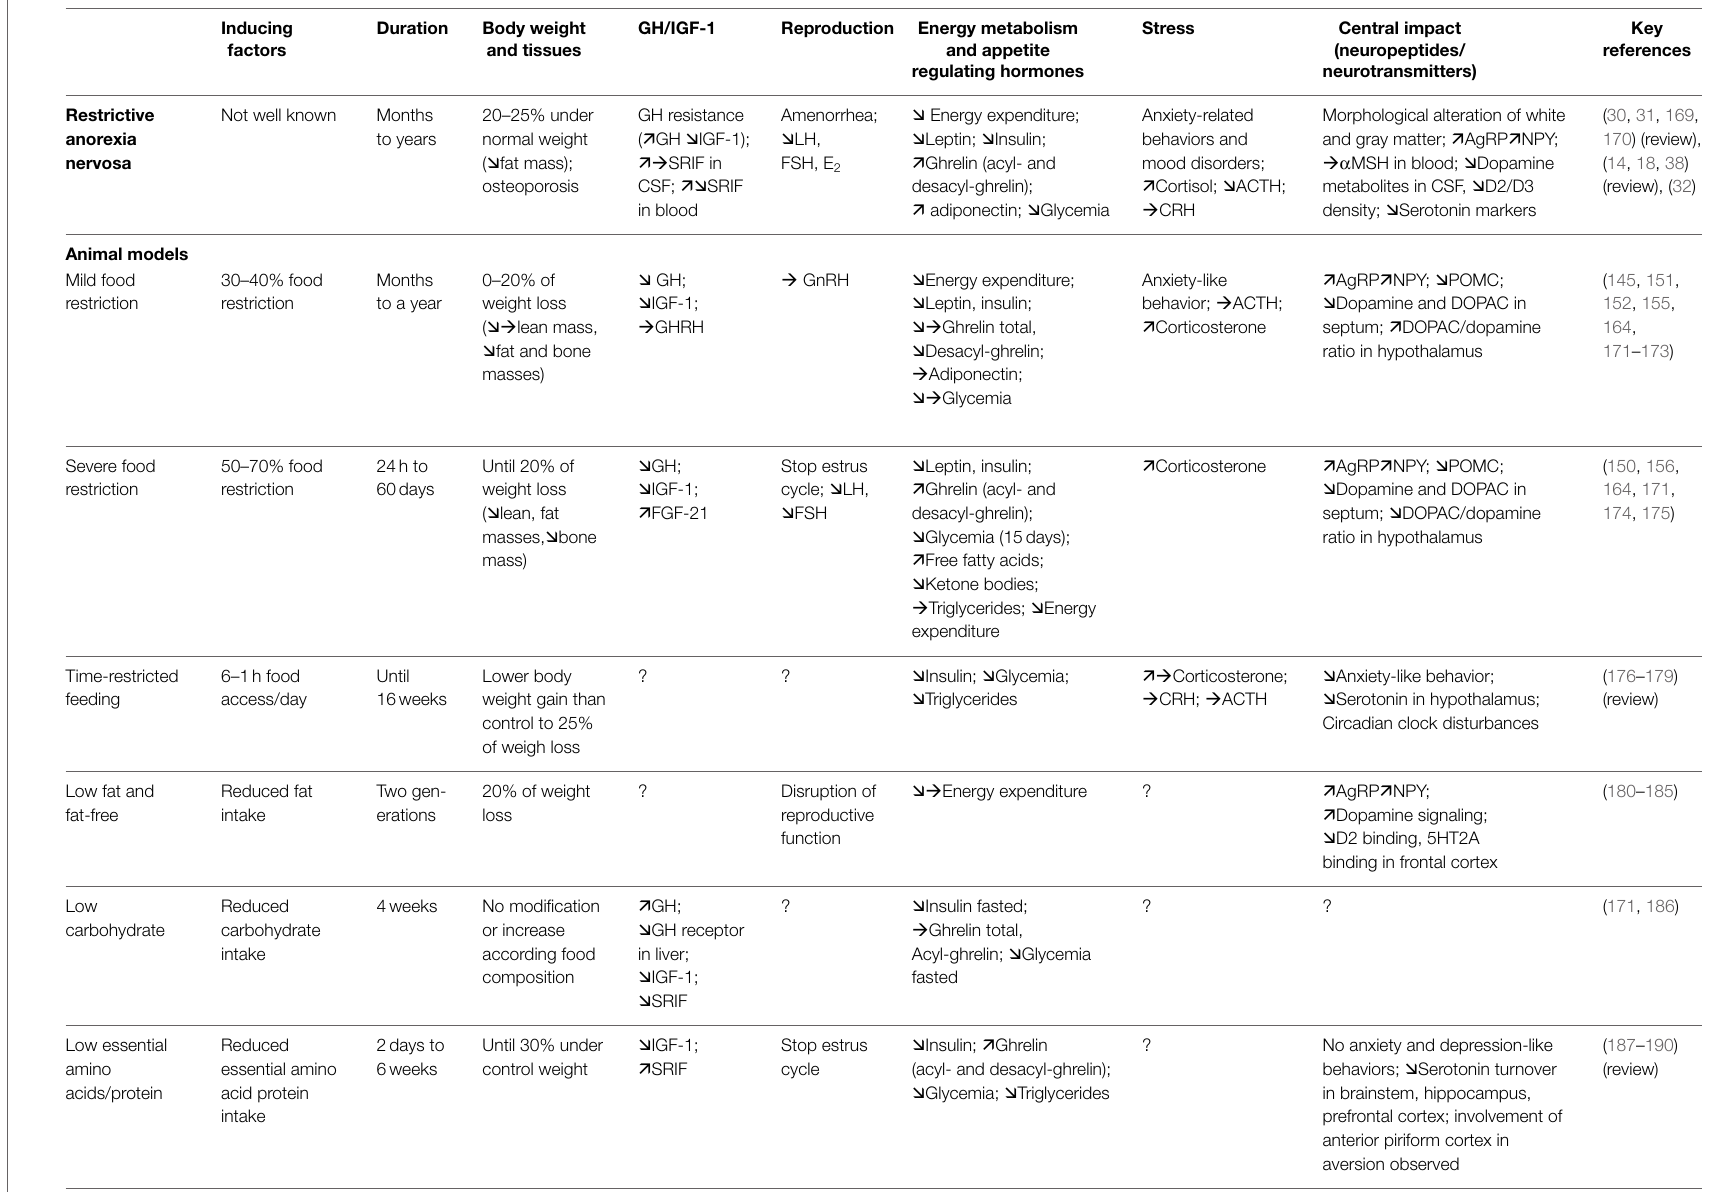
TABLE 3 | Environmental models: main physiological and neurobiological changes observed in rodent models manipulated for one or several factors